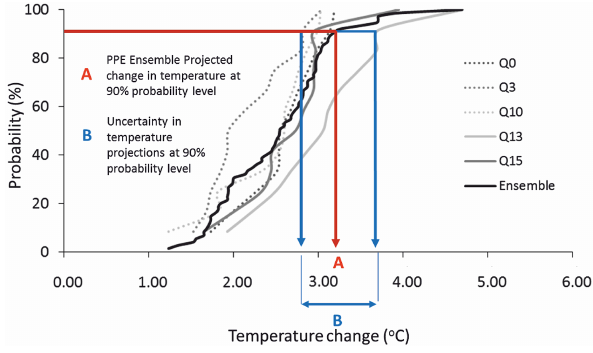
Figure 4. Calculations of (a) monthly change in temperature and (b) projected uncertainty from cumulative distribution functions of perturbed physics ensemble temperature data of the Holland River in